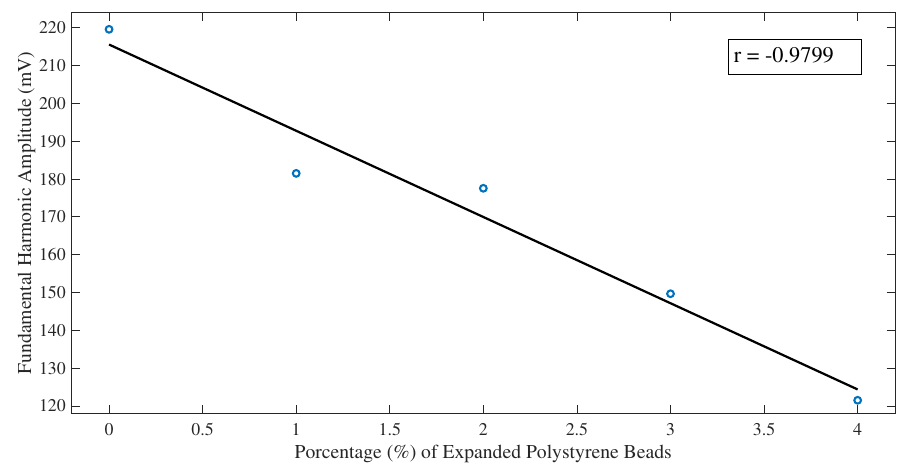
Figure 7. Fundamental harmonic amplitude averages over the window of the CFST samples using the FFT algorithm. The solid black line is a linear fit of the data. Pearson correlation coefficient r = −